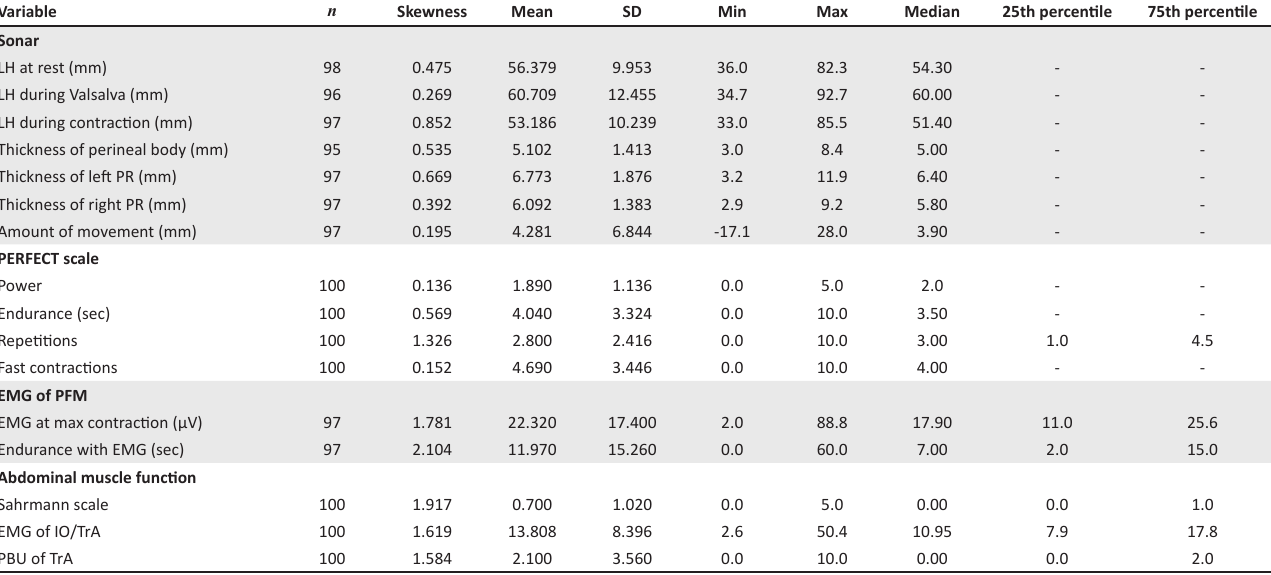
TABLE 2: Results for pelvic floor and abdominal muscle function.